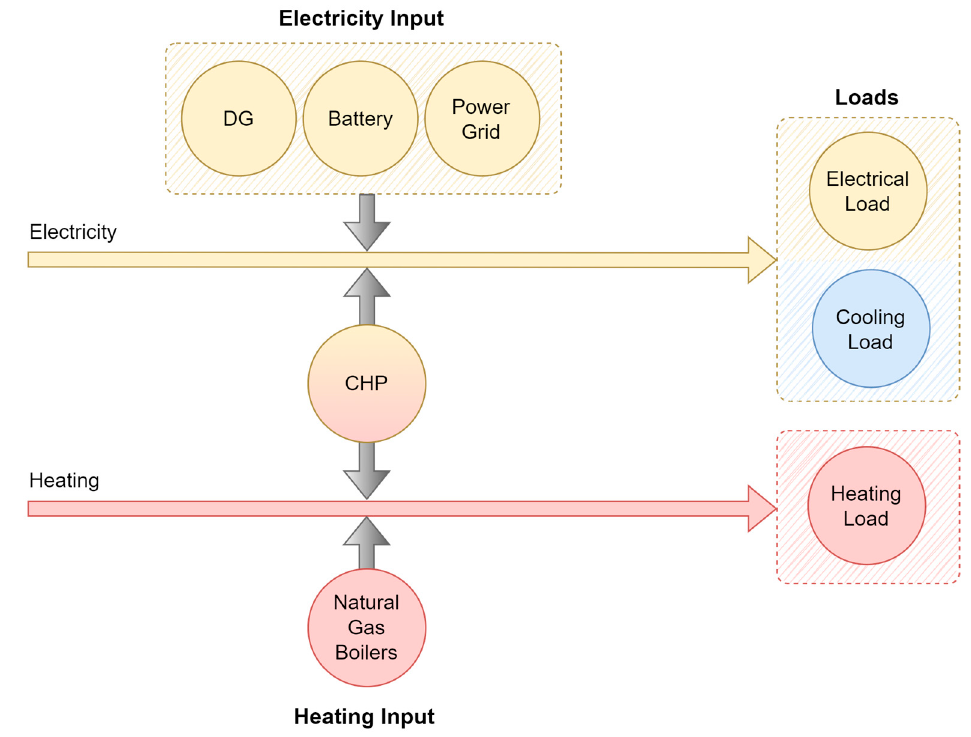
Figure 6. Example of an electrothermal diagram of a hybrid smart grid (based on [91]).